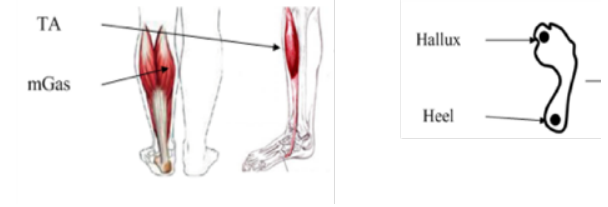
Figure 2: Electrode placement of footswitch and EMG signals